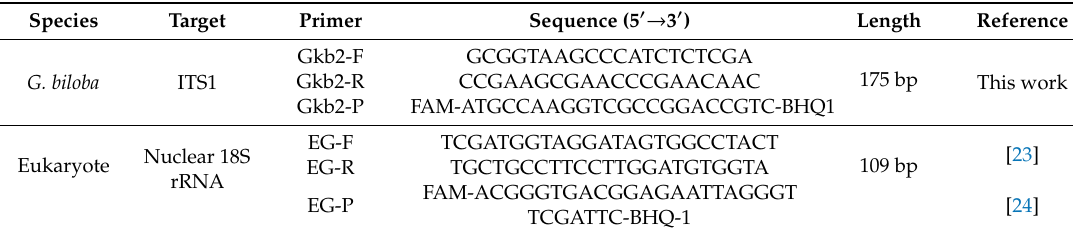
Table 2. Data of primers used, targeting the ITS1 region of Ginkgo biloba and a conserved eukaryotic